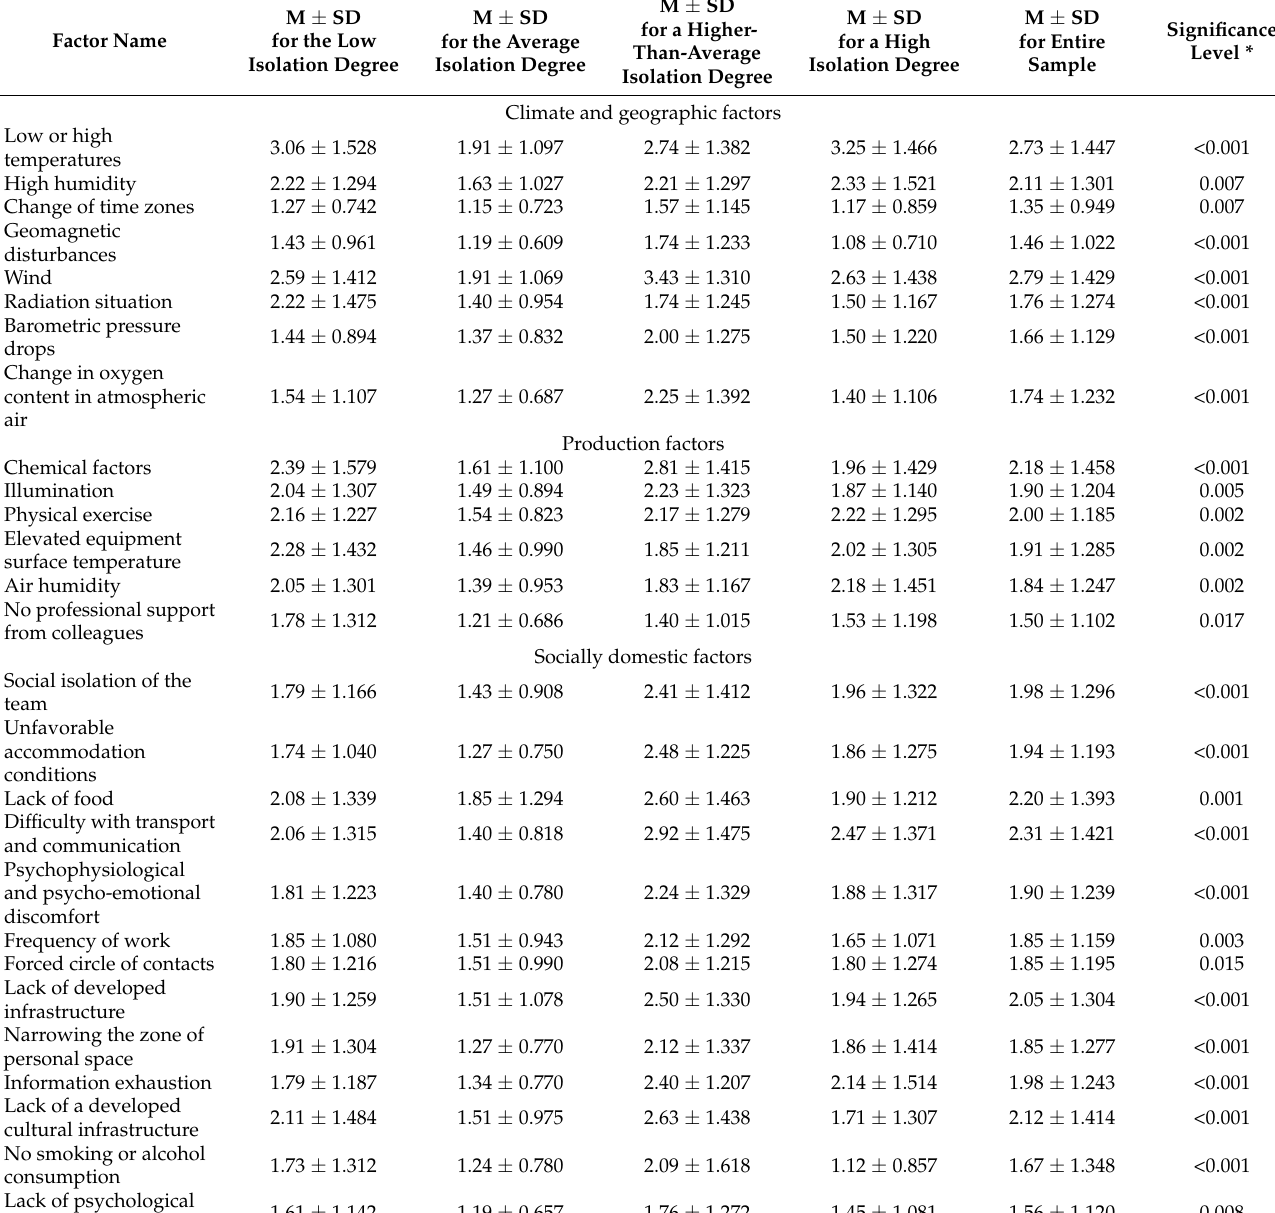
Table 3. Statistically significant differences according to univariate tests in the subjective assessment of the discomfort of climate and geographic, production and social factors for FIFO personnel with different degrees of group isolation (on a five-point scale, where 5 is the most uncomfortable factor, and 1 is the least